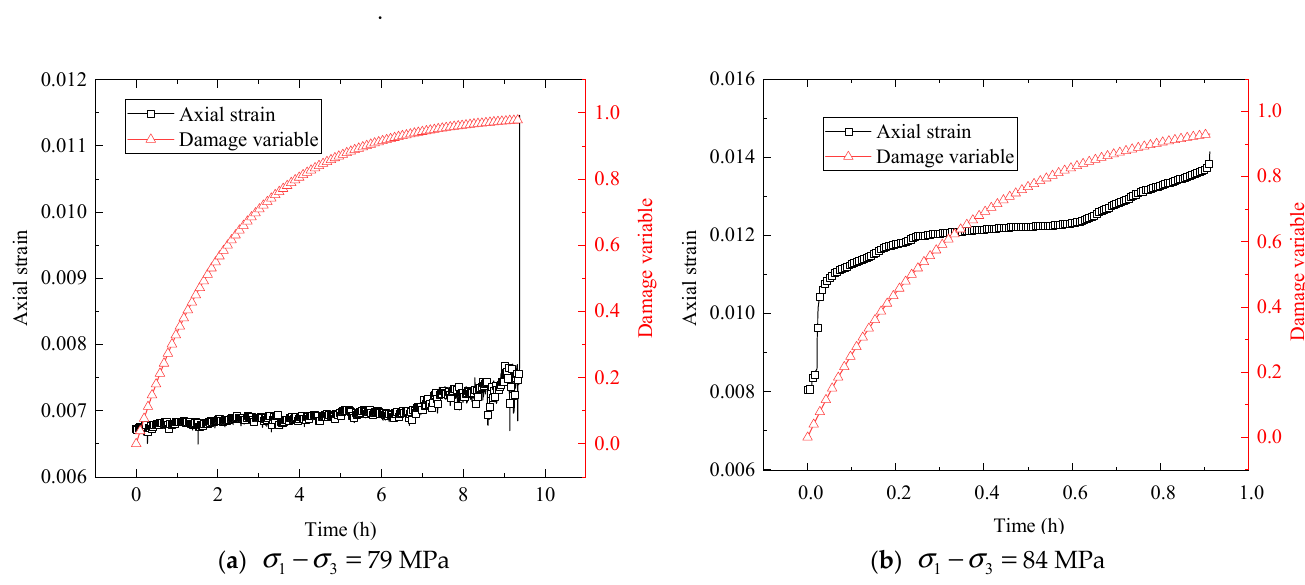
Figure 12. Evolution curves of damage variable– and strain–time under the last level of deviatoric stress at confining pressures of ( a ) 9 MPa and ( b ) 15 MPa.